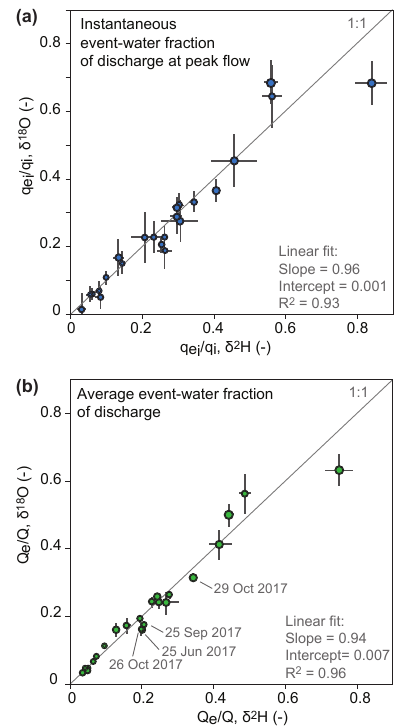
Figure 4. (a) Instantaneous event-water fractions of discharge at peak flow ( q e , i /q i ) as well as (b) whole-storm event-water fractions of discharge ( Q e /Q ) obtained from either δ 2 H or δ 18 O. The sizes of the data points reflect the precipitation totals of the storm events, and error bars show ± 1SE. For the 17 September 2017 storm, unre- alistic results were obtained for Q e when δ 18 O was used as a tracer; therefore this data point is excluded from the comparison analysis. Hydrograph separation results for δ 18 O are provided Table